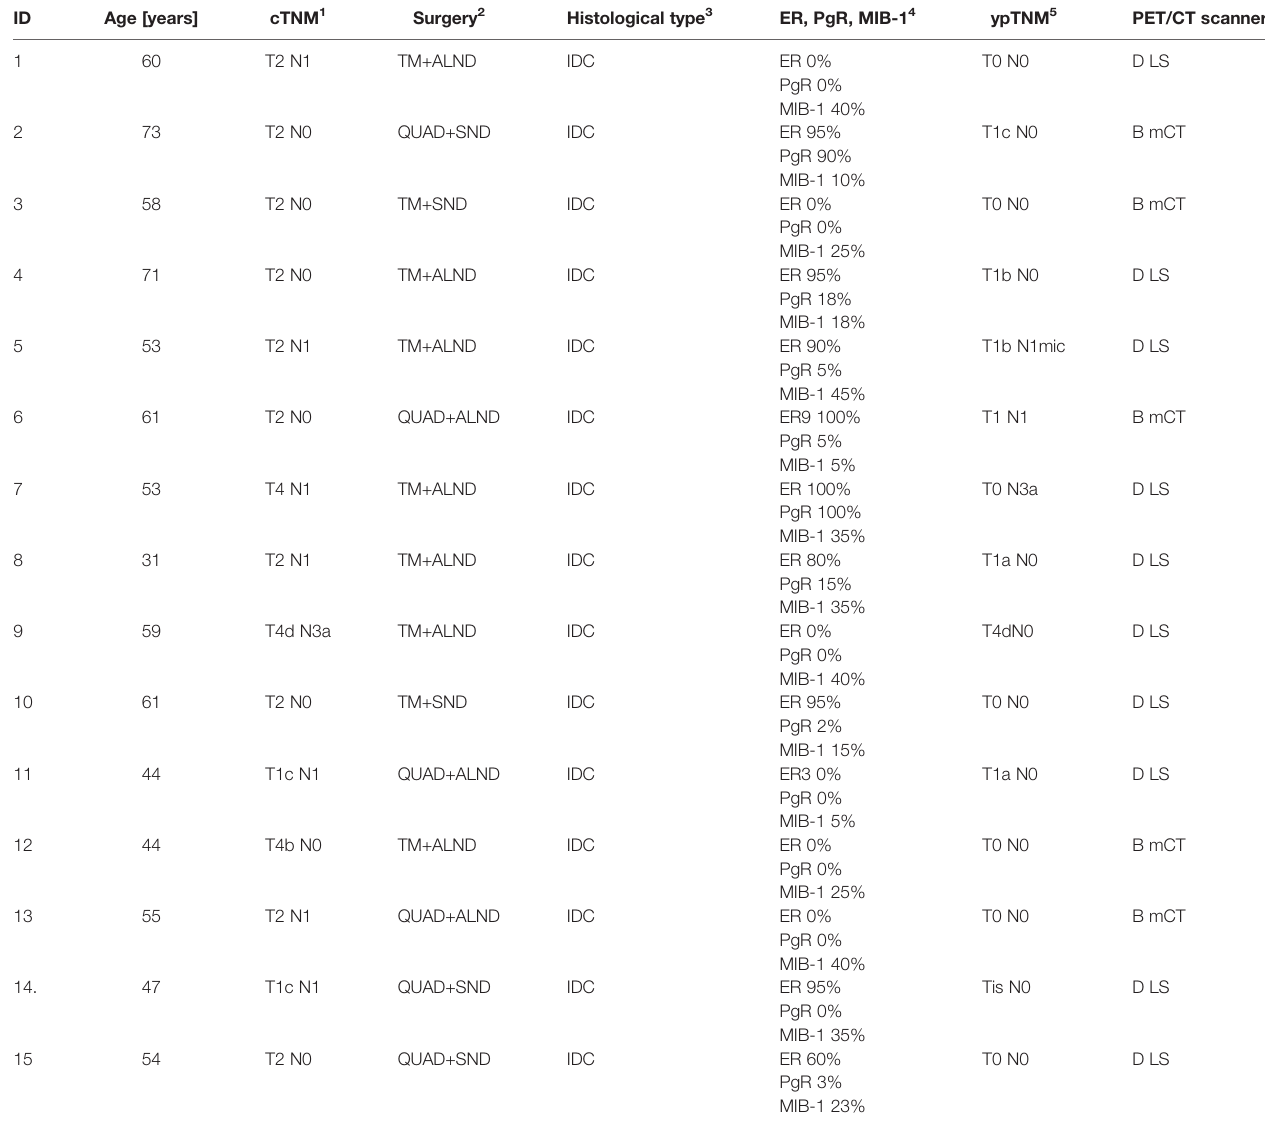
TABLE 1 | Main patient